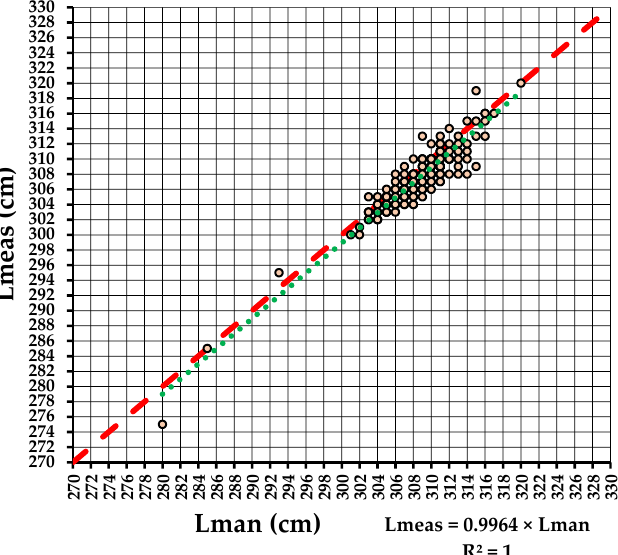
Figure 14. Relation between the lengths measured by the two methods (E2). Legend: red dashed line stands for perfect agreement and green dashed line stands for the dependence relation between Lmeas and Lman fitted by RTO.